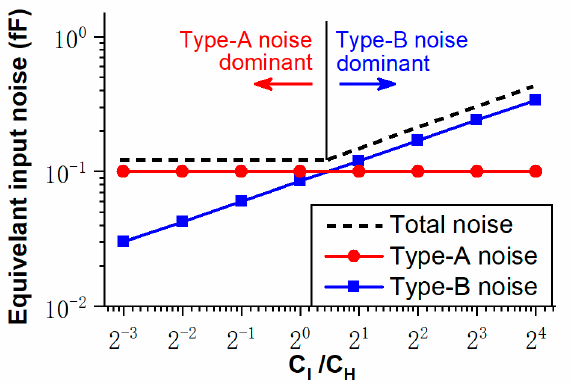
Figure 4. The relationship of type-A equivalent input noise, type-B equivalent input noise and ratio C I / C H